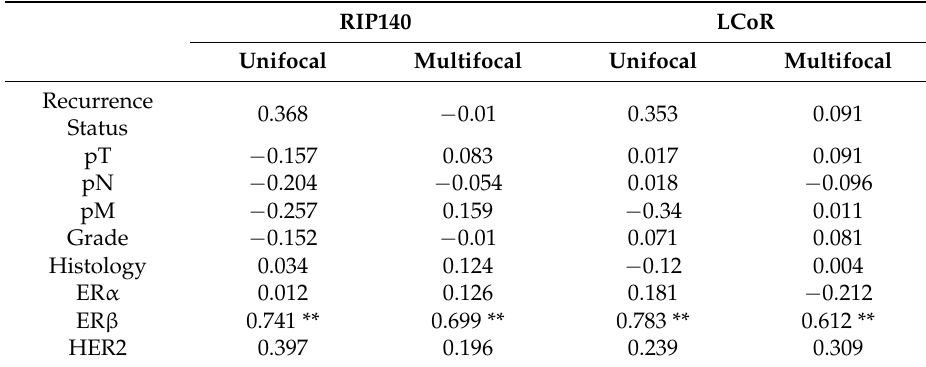
Table 3. Correlation analysis of RIP140 and LCoR expression with clinical parameters and estrogen receptor (ER) expression in unifocal versus multifocal breast